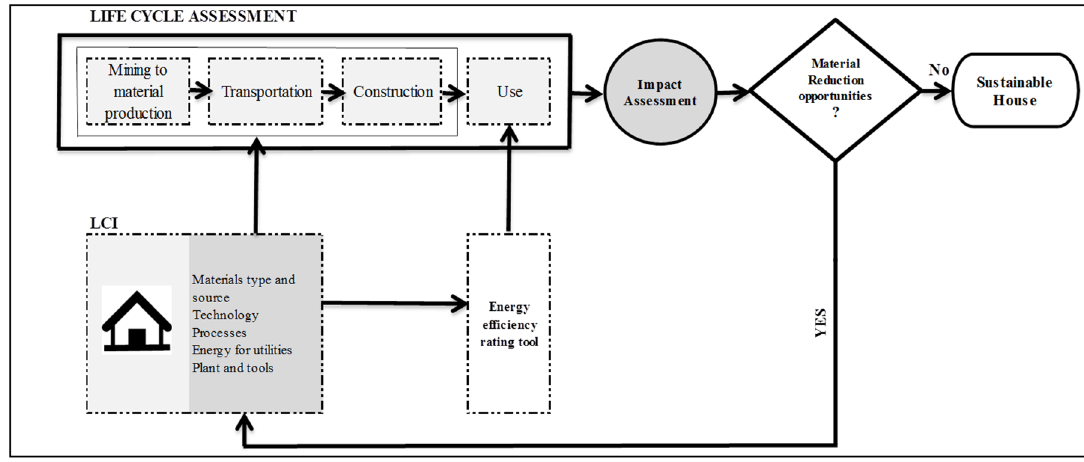
Figure 1. Life cycle management (LCM) framework.